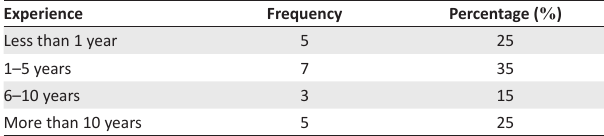
TABLE 3: Experience of District Civil Protection Unit